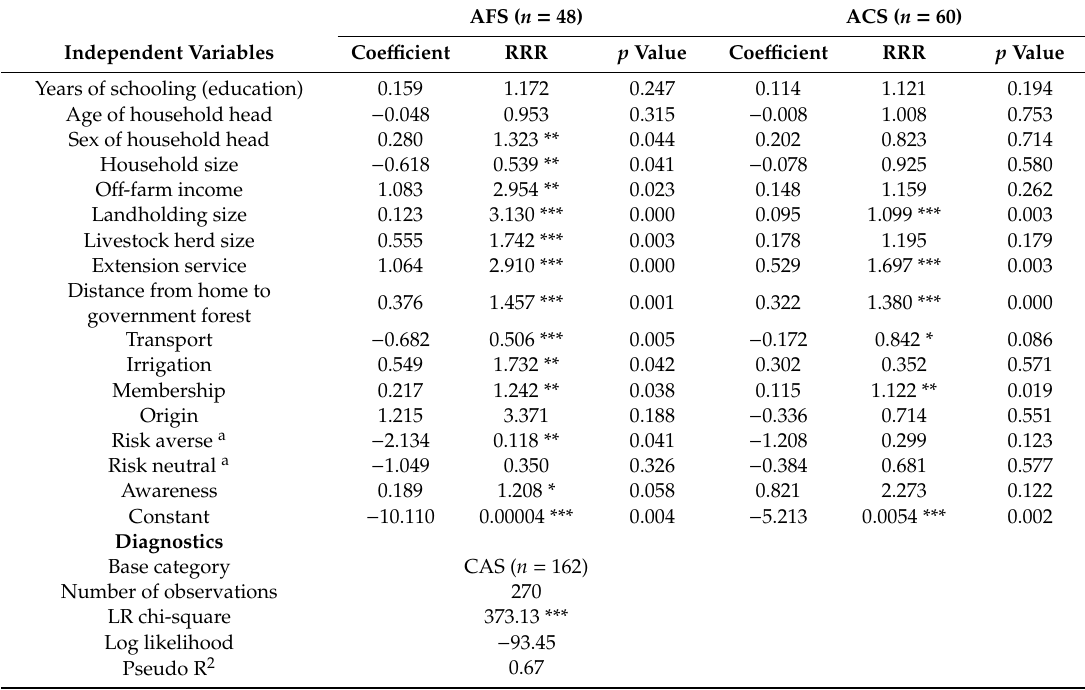
Table 3. Parameter estimates and RRR of a multinomial logistic model for AFS and